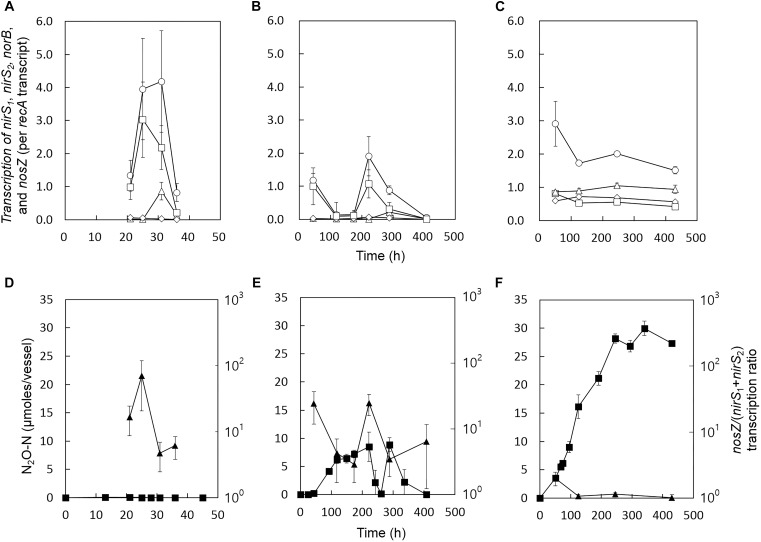
Transcription profiles of nirS1 (Δ), nirS2 (), norB (), and nosZ () in the D. aromatica strain RCB cultures incubated at (A) the control condition, (B) the salt stress condition, and (C) the alkaline stress condition. The samples for the RT-qPCR analyses were withdrawn from the same culture vessels used to construct Figure 1. The transcript copy numbers of the denitrification genes were normalized with the copy numbers of recA transcripts. The data points represent the averages of three biological replicates processed independently through RNA extraction and reverse transcription procedures. The error bars represent the standard deviations of the triplicate samples. The values of nosZ/(nirS1+nirS2) () calculated with the nirS1, nirS2, and nosZ transcription data in panels (A–C) are presented in panels (D–F), respectively. The errors were calculated using the propagation of error. The amounts of N2O () are included for convenient comparison between the datasets.